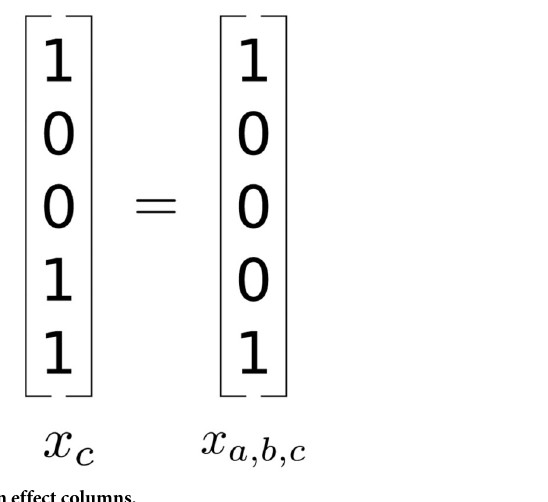
Fig 1. Creation of three-way interaction effect